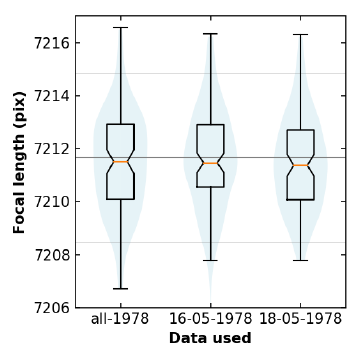
Figure 3. Violin-plots of principal distance estimated with 100 bootstraps, sampling 70% of initial tie points. The solid horizontal line represents the principal distance estimated once with 100% of tie points (67 073 points). The thin horizontal is the 1-  error on principal point estimate. Three situations are tested. All-1978 estimates the principal distance using all photos flown in 1978, thus more redundant than classically minimal stereoscopic conditions (60% overlap, 30% side lap). 16-05-1978 estimates the focal distance only using 12 photos in 3 flight bands with 60% overlap and 30% side-lap. 18-05-1978 estimates using 21 photos in 4 flight bands with 60% overlap and 30%